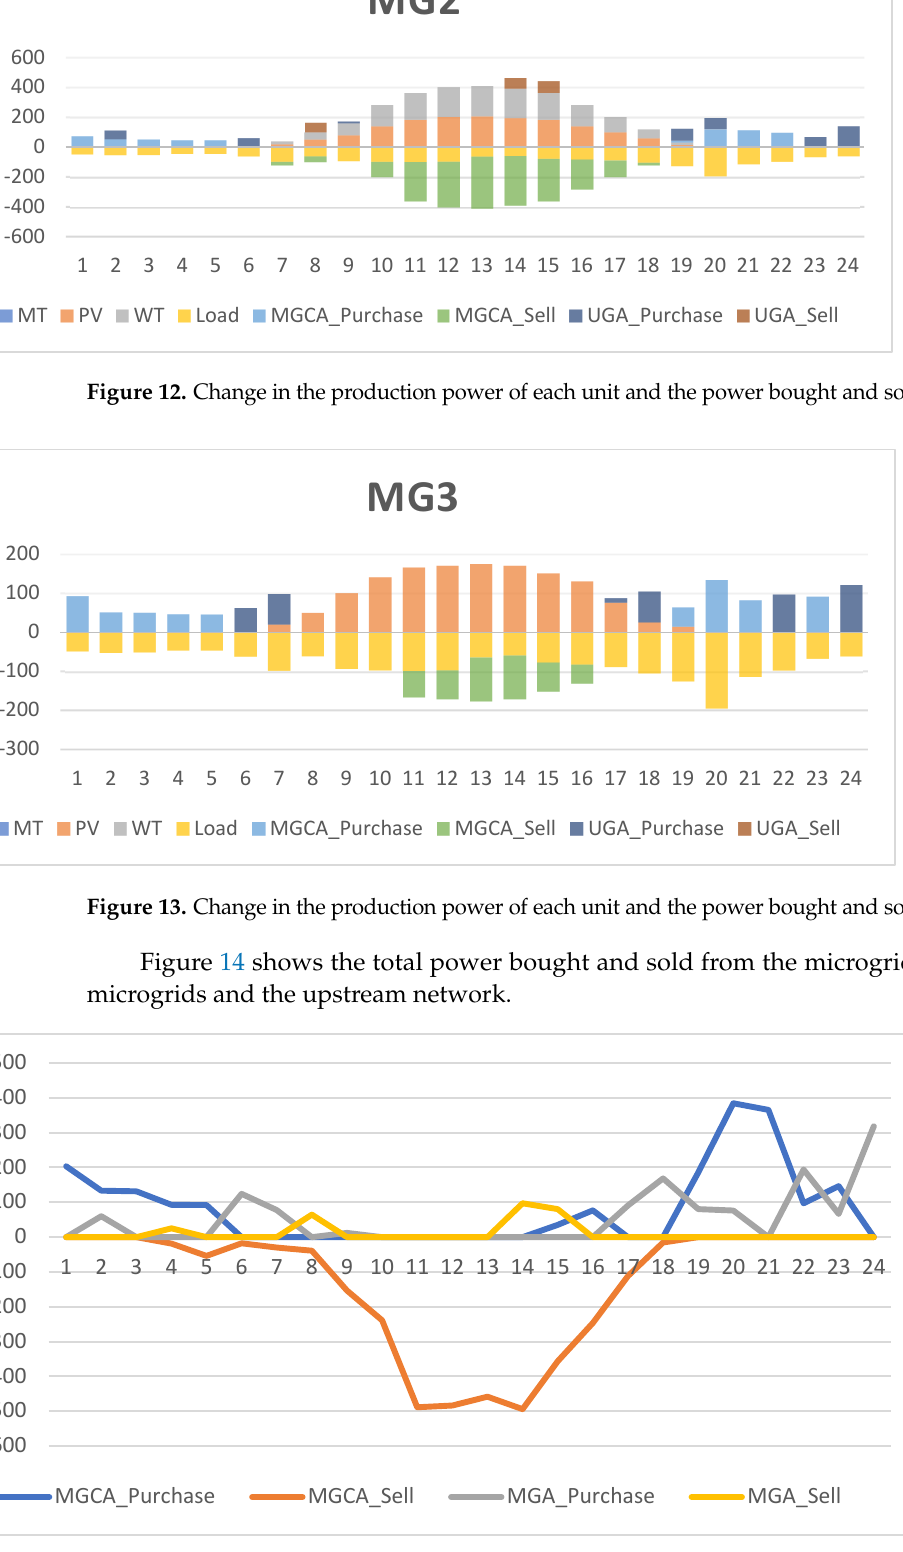
Figure 14. Total power bought and sold from microgrid cluster to each microgrid and upstream network.